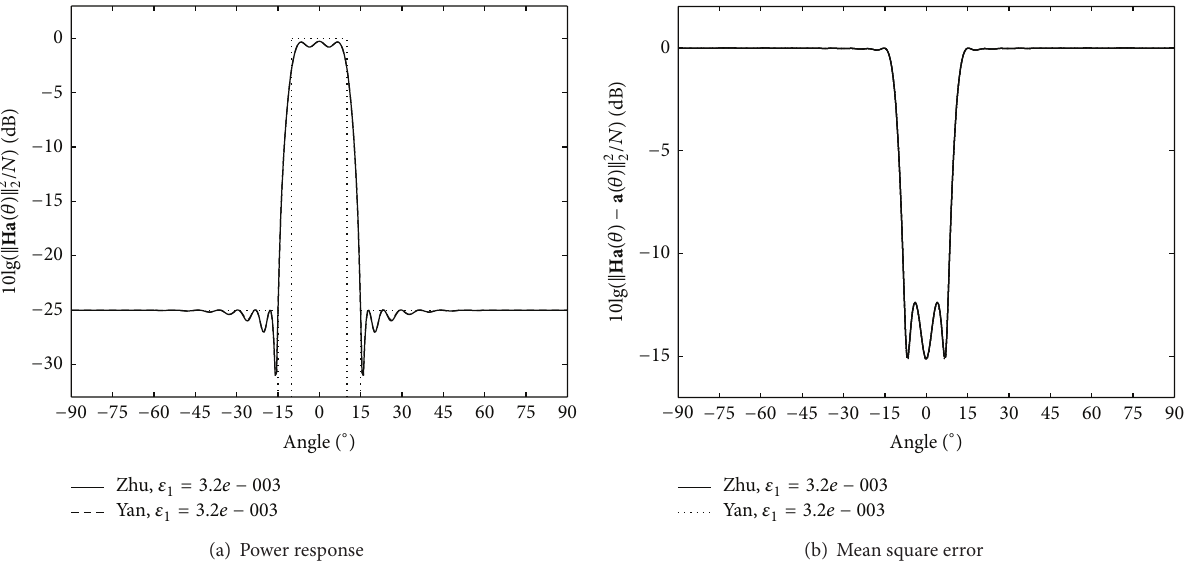
Figure 2: The comparison of Zhu method [8] with Yan method